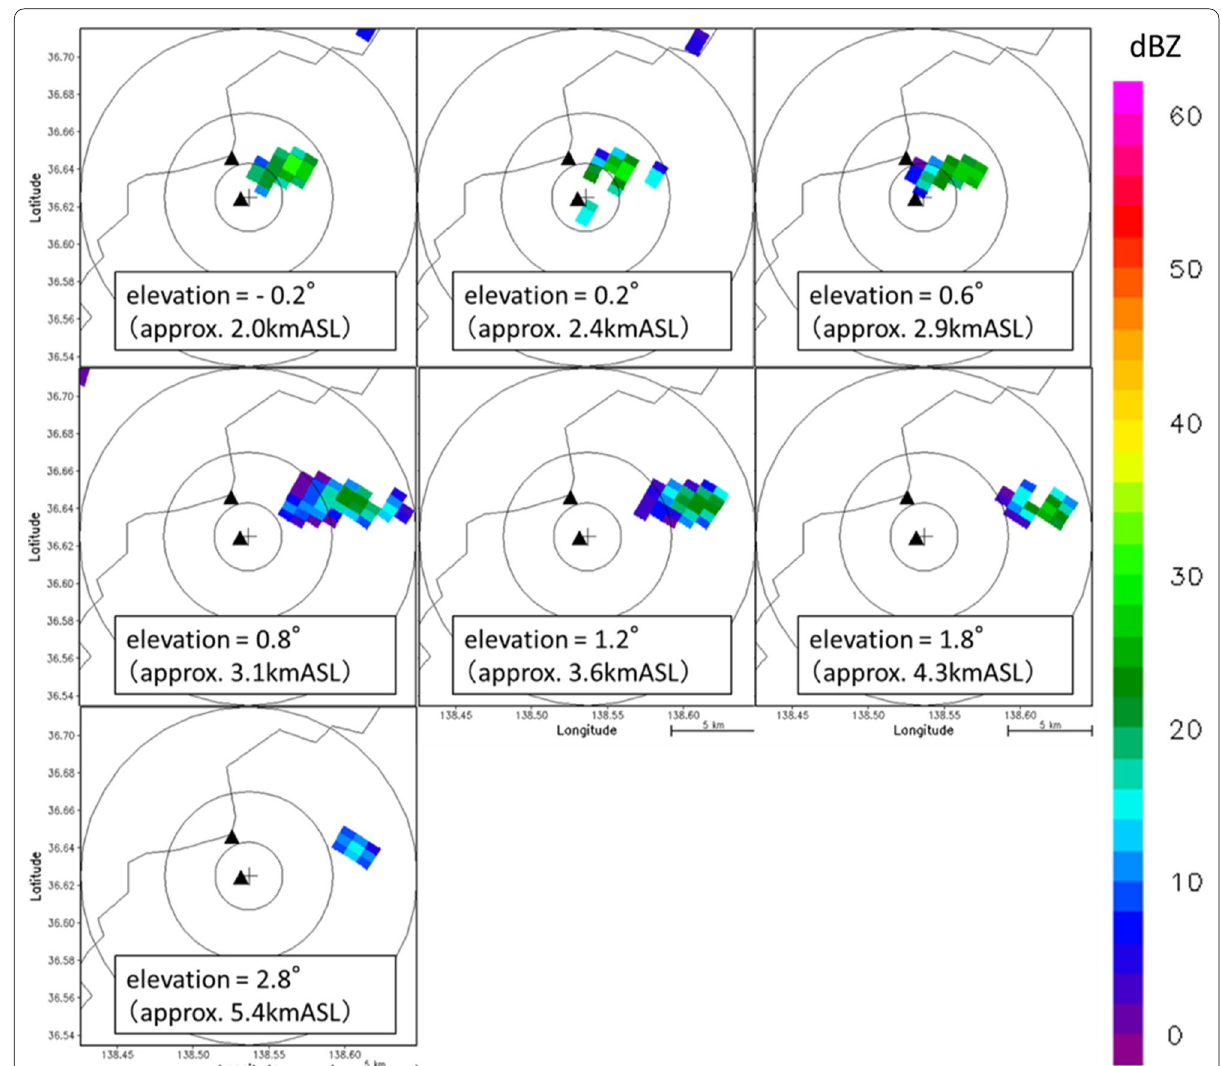
Fig. 2 Reflectivity images observed by Nagano radar between 10:05 and 10:10 JST on January 23, 2018. Black triangles show summits of Motoshirane and Shirane. Concentric circles show 2, 5, and 10 km from the v (